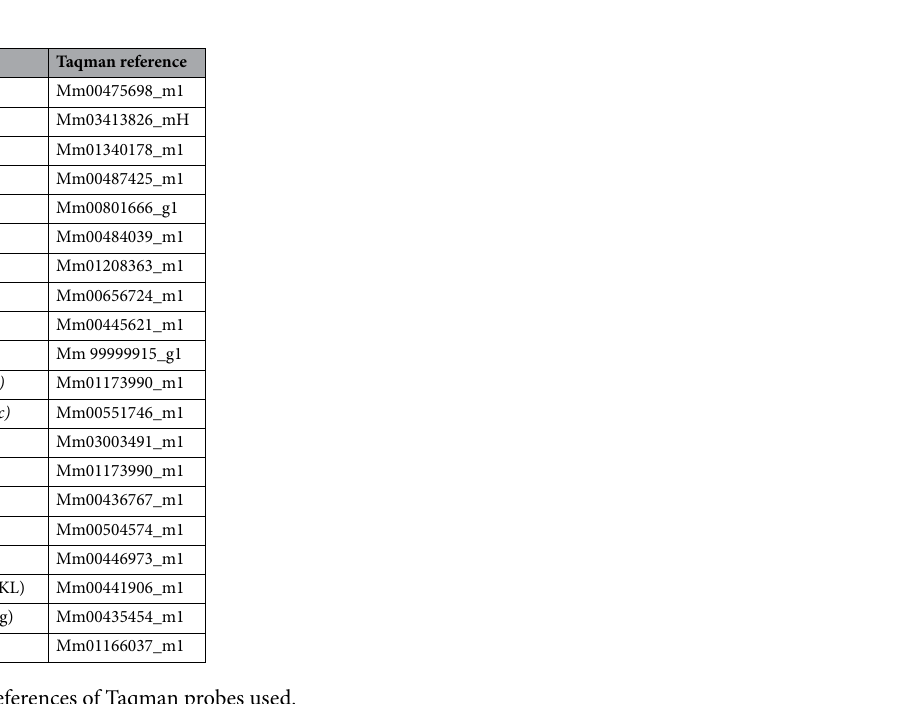
Table 2. References of Taqman probes